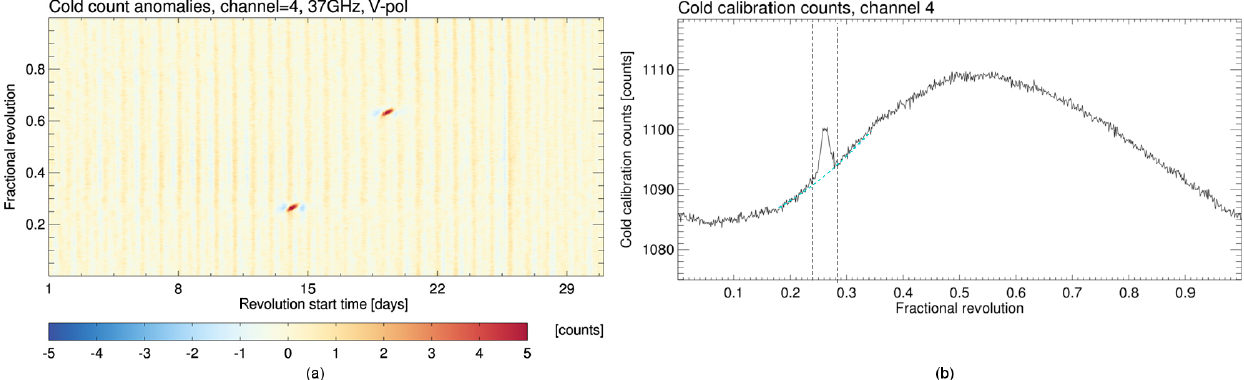
Figure 3. Cold count anomaly (a) from the SSM/I F13 channel at 37GHz, v-pol for November 2005. The y axis represents the fractional orbit angle with an ascending Equator crossing at 0 and descending Equator crossing at 0.5. The x axis represents the time of the orbit start at the ascending Equator crossing. A cross section of the absolute cold counts through the maximum of the first intrusion event is shown in (b) . Positions with identified cold count anomalies are between the vertical lines. The locally fitted reconstruction spline is plotted in